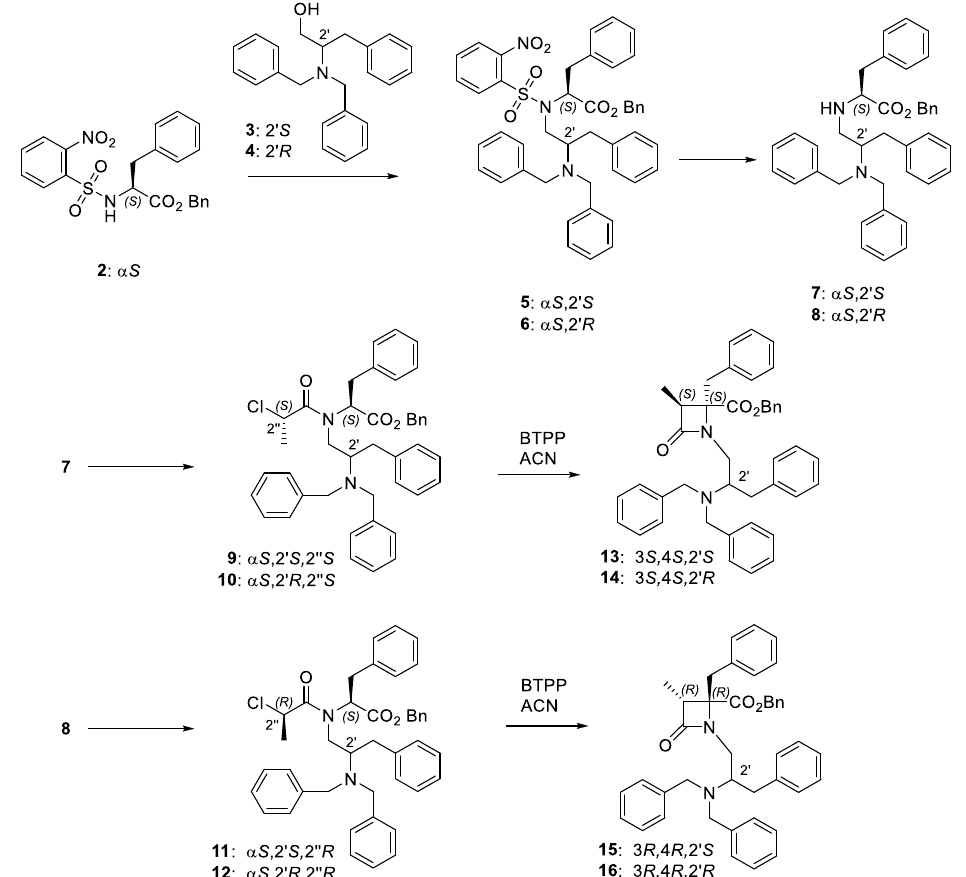
Scheme 1. Synthetic pathway for the preparation of the four diastereoisomeric β -lactam deriva- tives.